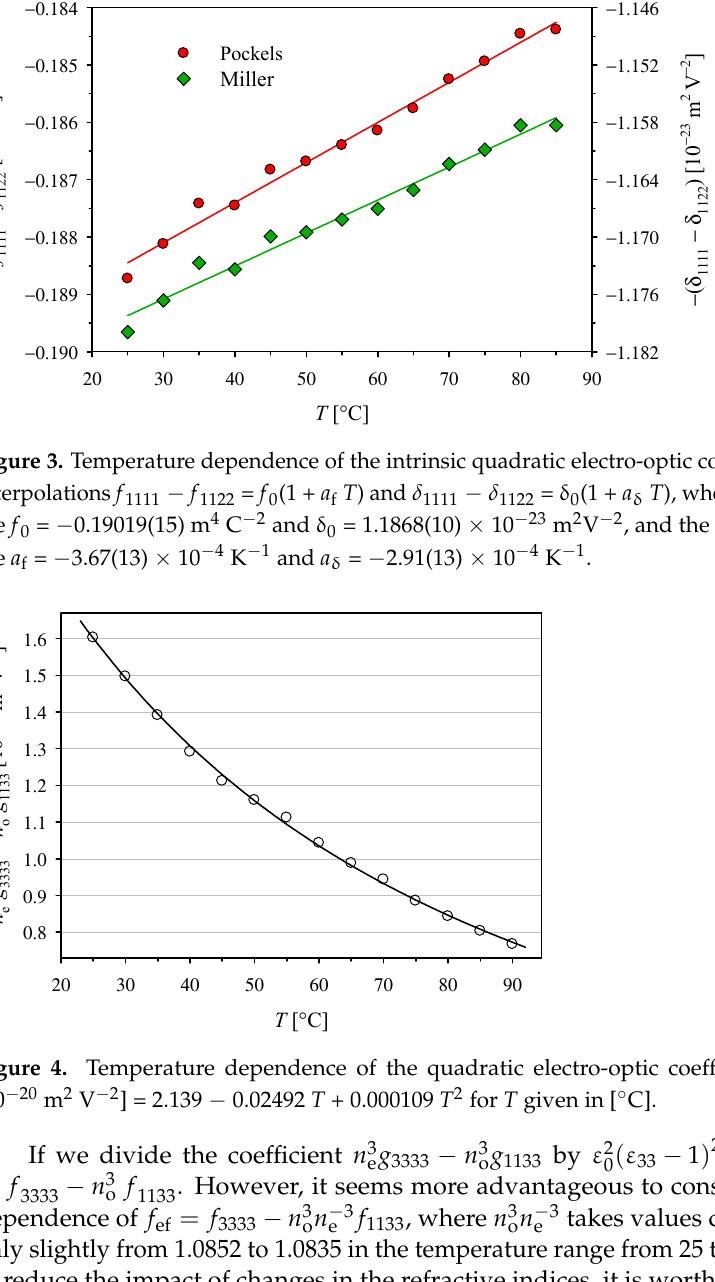
− n o3 g effec- 3333 1133